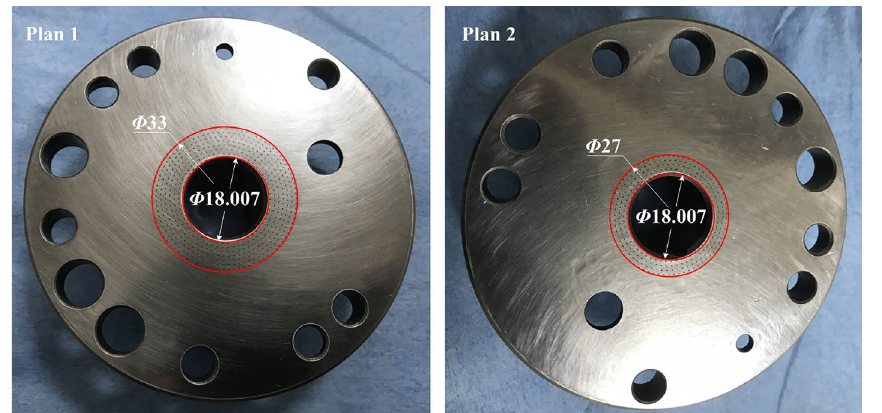
Figure 13. Photographs of bottom bearing with